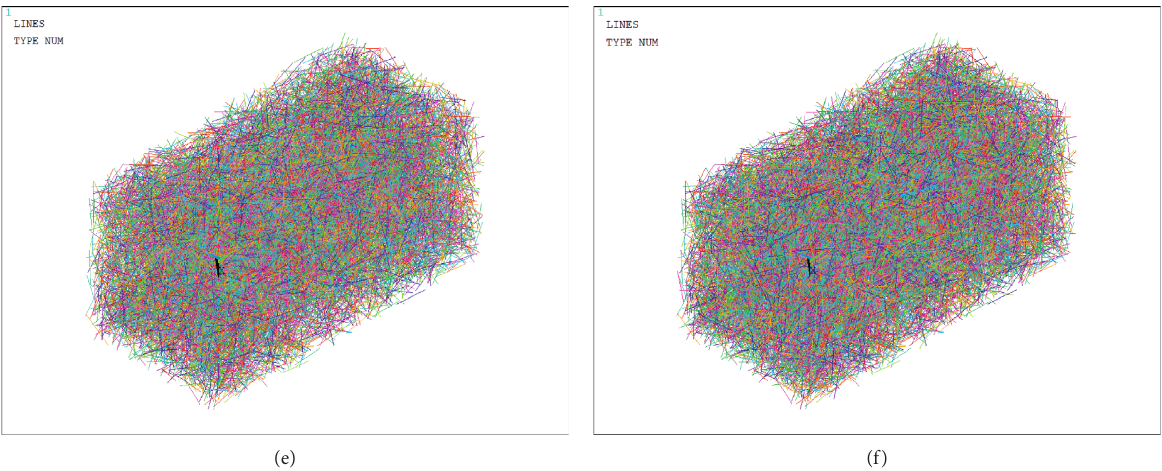
Figure 2: Fibre generation with different fibre volume ratios. (a) V V f �